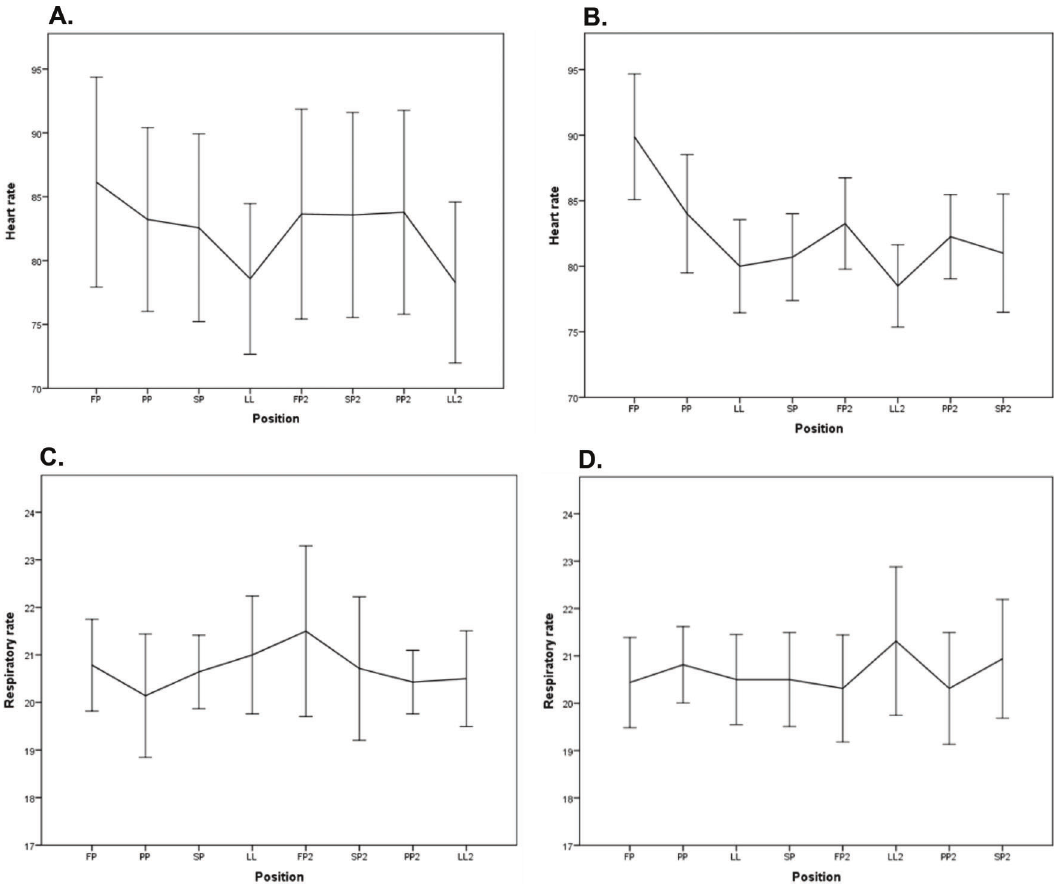
Figure 4 - Graphical representation of the heart rates of the pregnant women who performed sequence 1 (A) and sequence 2 (B). Graphical representation of the respiratory rates of the pregnant women who performed sequence 1 (C) and sequence 2